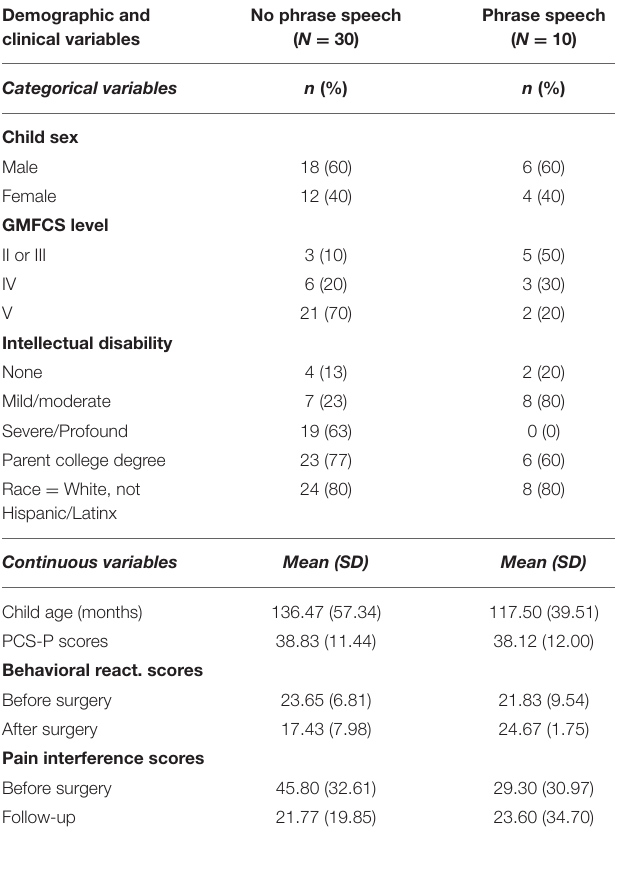
TABLE 2 | Summary of demographic and clinical characteristics by spoken language status. Demographic and clinical variables